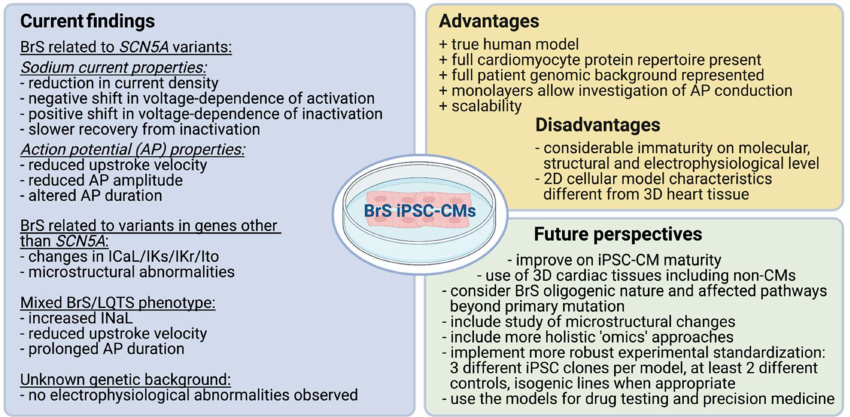
Figure 2. Summary of the main findings from the reviewed BrS iPSC-CM models, advantages and disadvantages of the model, as well as future perspectives for the use of iPSC-CMs in BrS research. (Generated with Biorender.com March